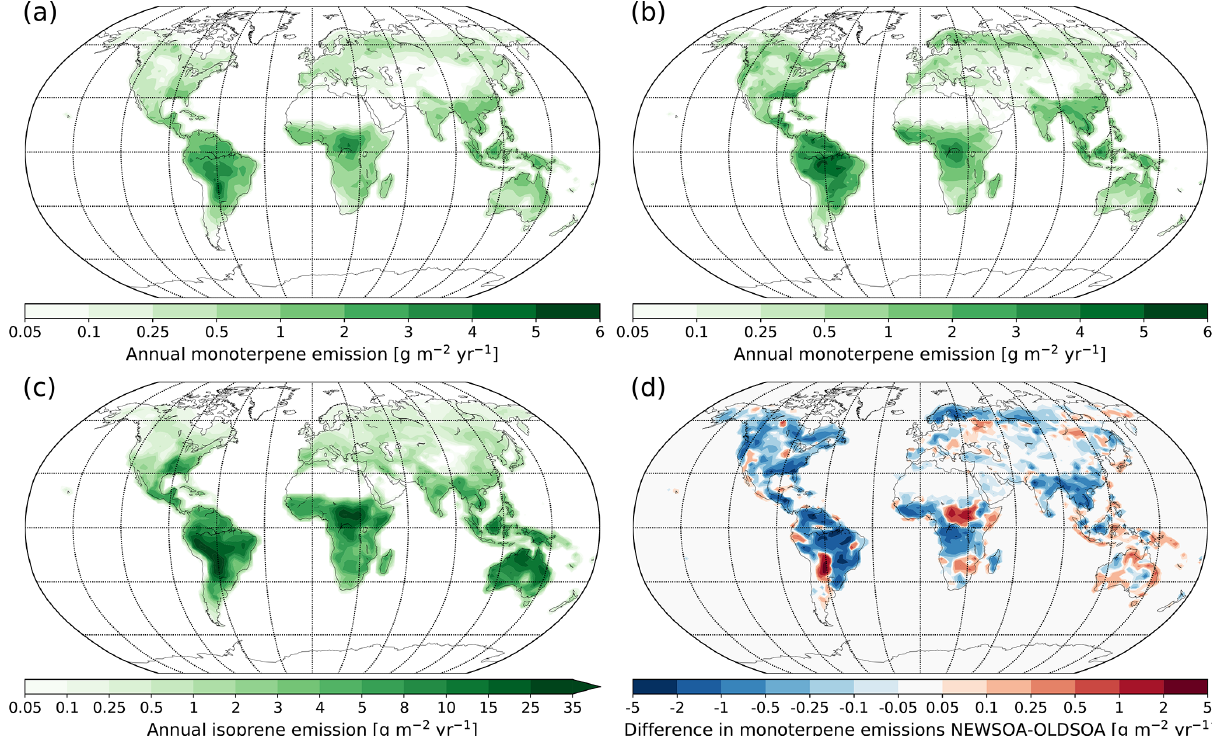
Figure 2. Annual emissions of monoterpene in the (a) new scheme and (b) old scheme, along with annul emissions of (c) isoprene and (d) the difference in monoterpene emissions (red indicates increased emissions in the new